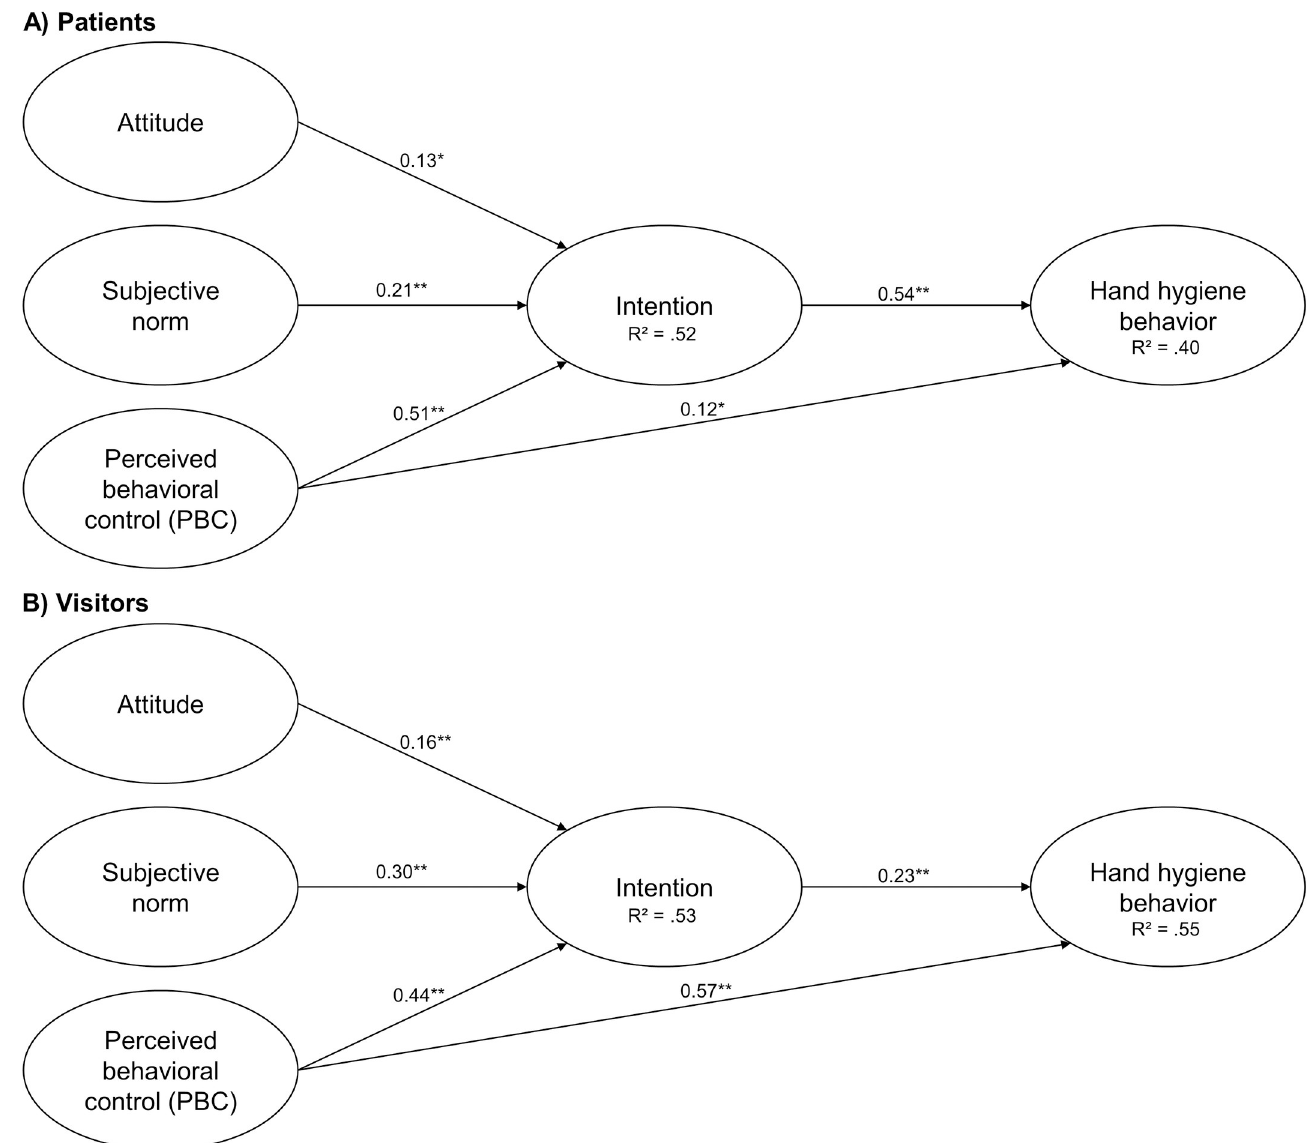
Fig 2. TPB path models with standardized parameter estimates to predict hand hygiene behavior. Note: � p < .05, �� p < .001, n (total patients) = n (used patients) = 286, n = 251, n = (total visitors) (used visitors)